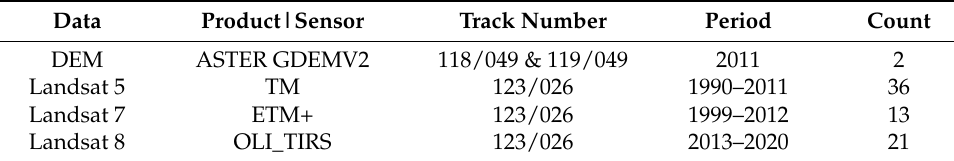
Figure 1. Study area. ( a ) is the location map, ( b ) is the true color remote sensing image, and ( c ) is the elevation map. (I) is the floodplain wetland area, (II) is the meadow area, and (III) is the sand ribbon area. Table 1. Spatial data information.